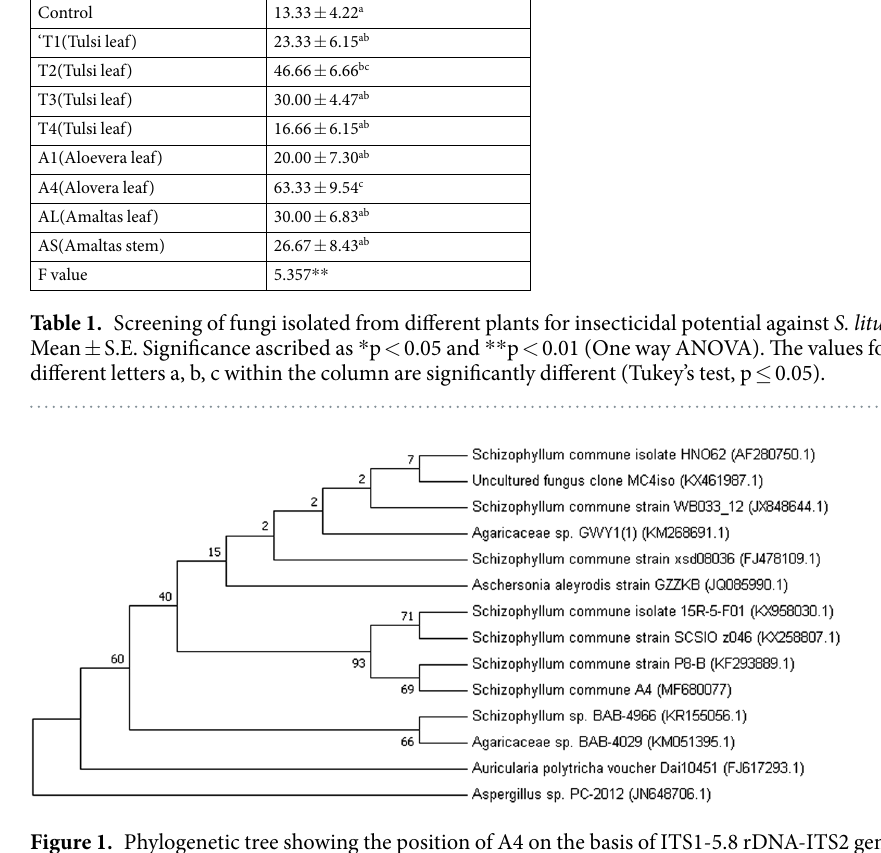
Figure 1. Phylogenetic tree showing the position of A4 on the basis of ITS1-5.8 rDNA-ITS2 gene sequence analysis. The evolutionary history was inferred using the Neighbor-Joining method. The bootstrap consensus tree inferred from 1000 replicates is taken to represent the evolutionary history of the taxa analyzed. The percentage of replicate trees in which the associated taxa clustered together in the bootstrap test (1000 replicates) are shown next to the branches. The evolutionary distances were computed using the Kimura 2-parameter method and are in the units of the number of base substitutions per site. The analysis involved 14 nucleotide sequences. Codon positions included were 1st + 2nd + 3rd + Noncoding. All positions containing gaps and missing data were eliminated. There were a total of 521 positions in the final dataset. Evolutionary analyses were conducted in